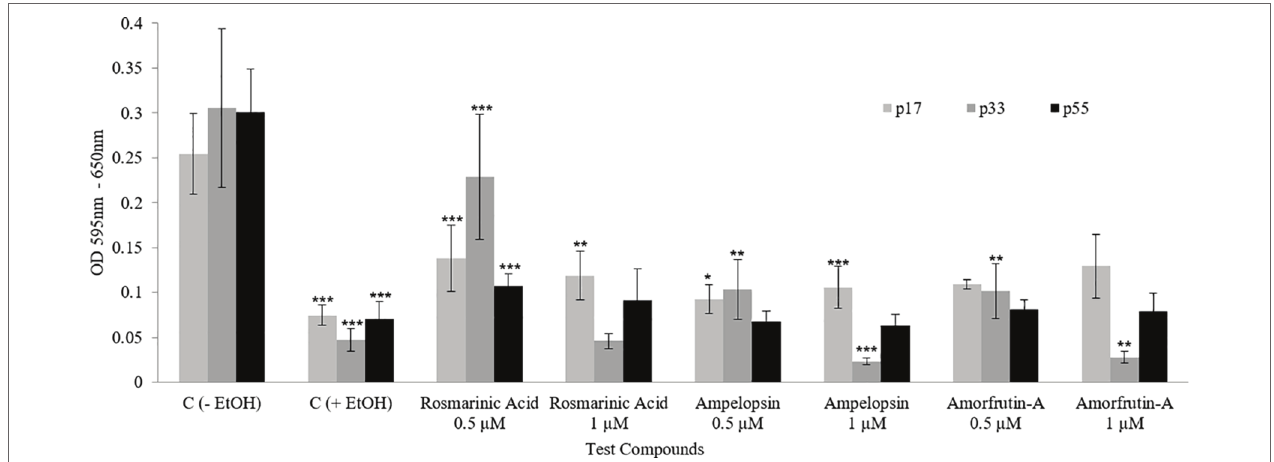
FIGURE 7 | Ethanol stress tolerance of PCS cells at three ages (p17, p33, and p55) of serially passaged PCS cells with or without continuous exposure to selected doses of test compounds, as determined by the MTT assay. The bars indicate the ±SD; n = 6, in terms of independent wells; *** p < 0.001, ** p < 0.01, * p < 0.05; as determined by Student’s t